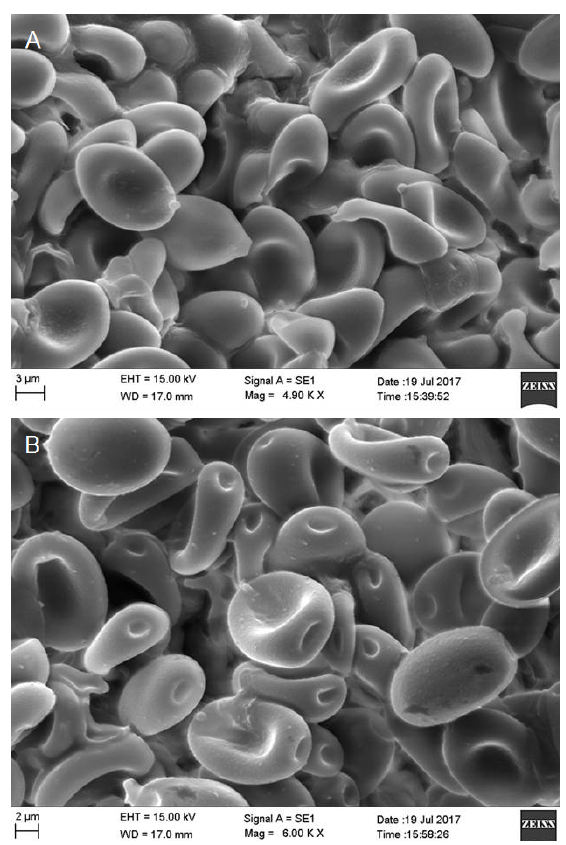
Figure 2 Psathyrella ammophila . ( A,B ) Basidiospores seen by SEM. Photographs by M. M.